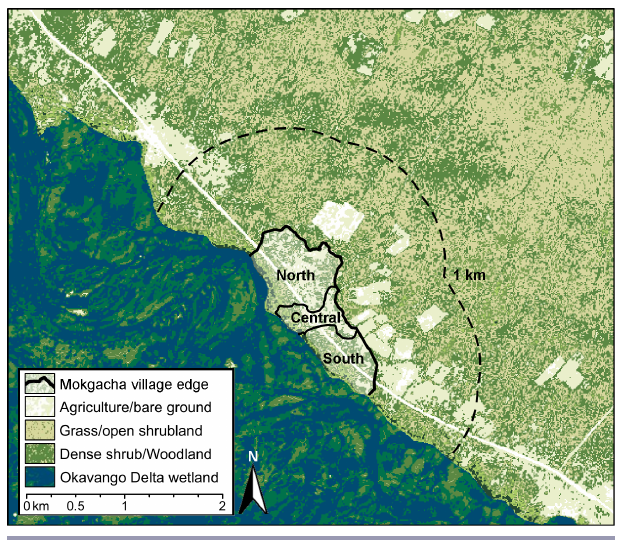
Fig. 7 . Mokgacha village by residence section, with a 1- kilometer buffer around the village edge to indicate where people often harvest